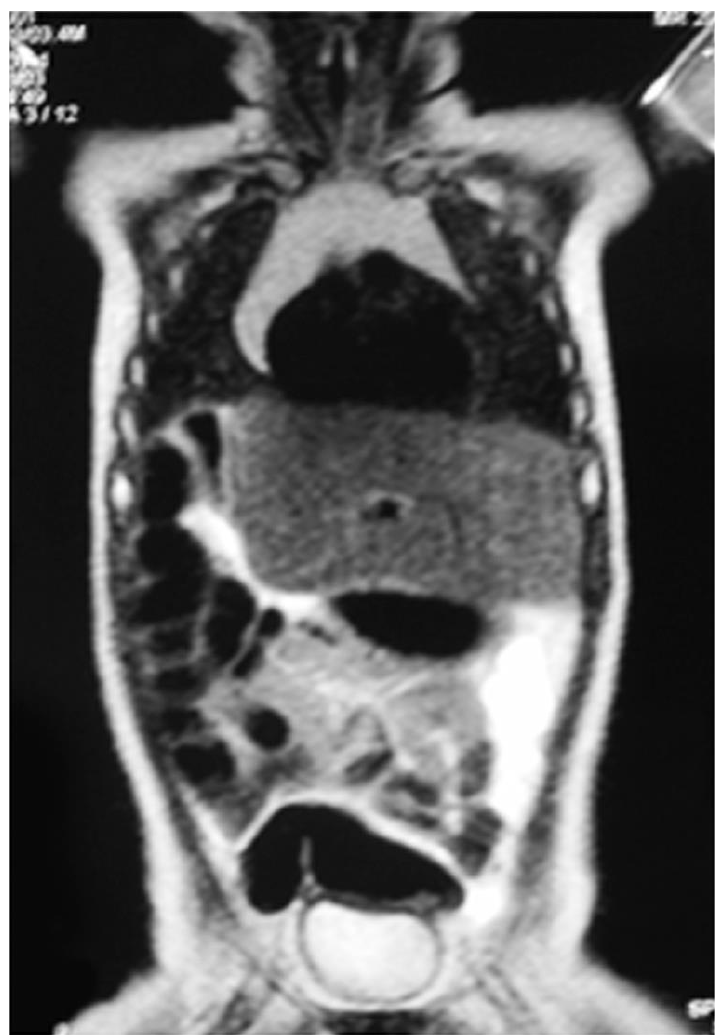
Figure 2. Total body MRI at 6 months follow-up showing no recurrence of